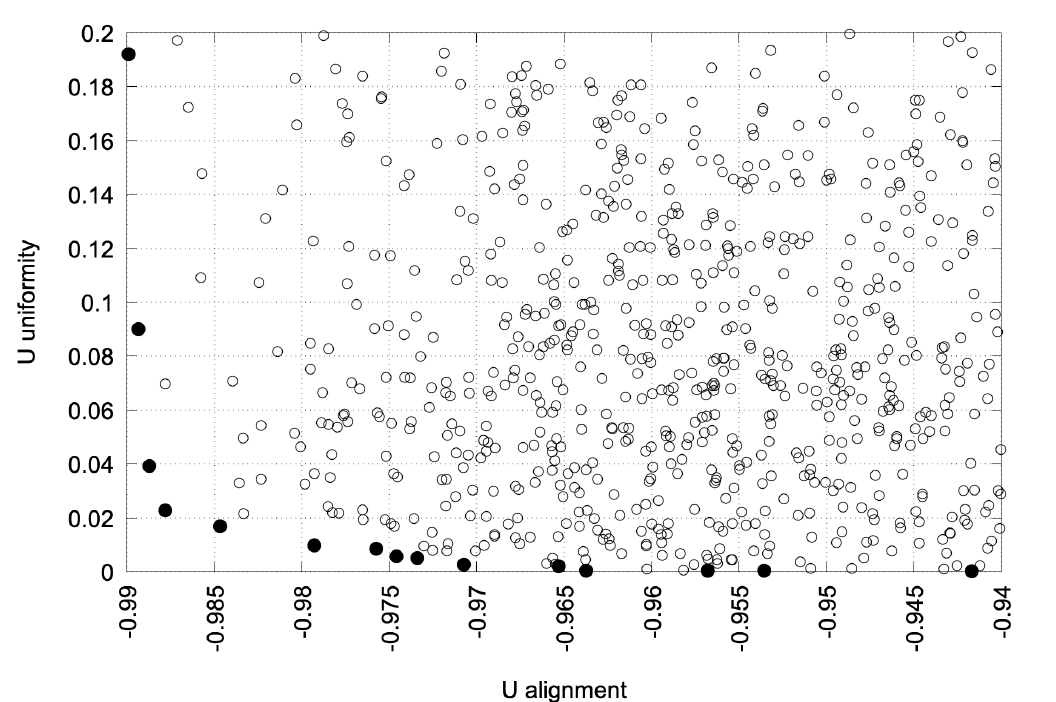
Figure 6. Perspective view of he hull surface (JBC) together with the FFD box for this hull parameterization. Green dots are representing the nodes of the FFD, and only 9 of them can move trasversally.